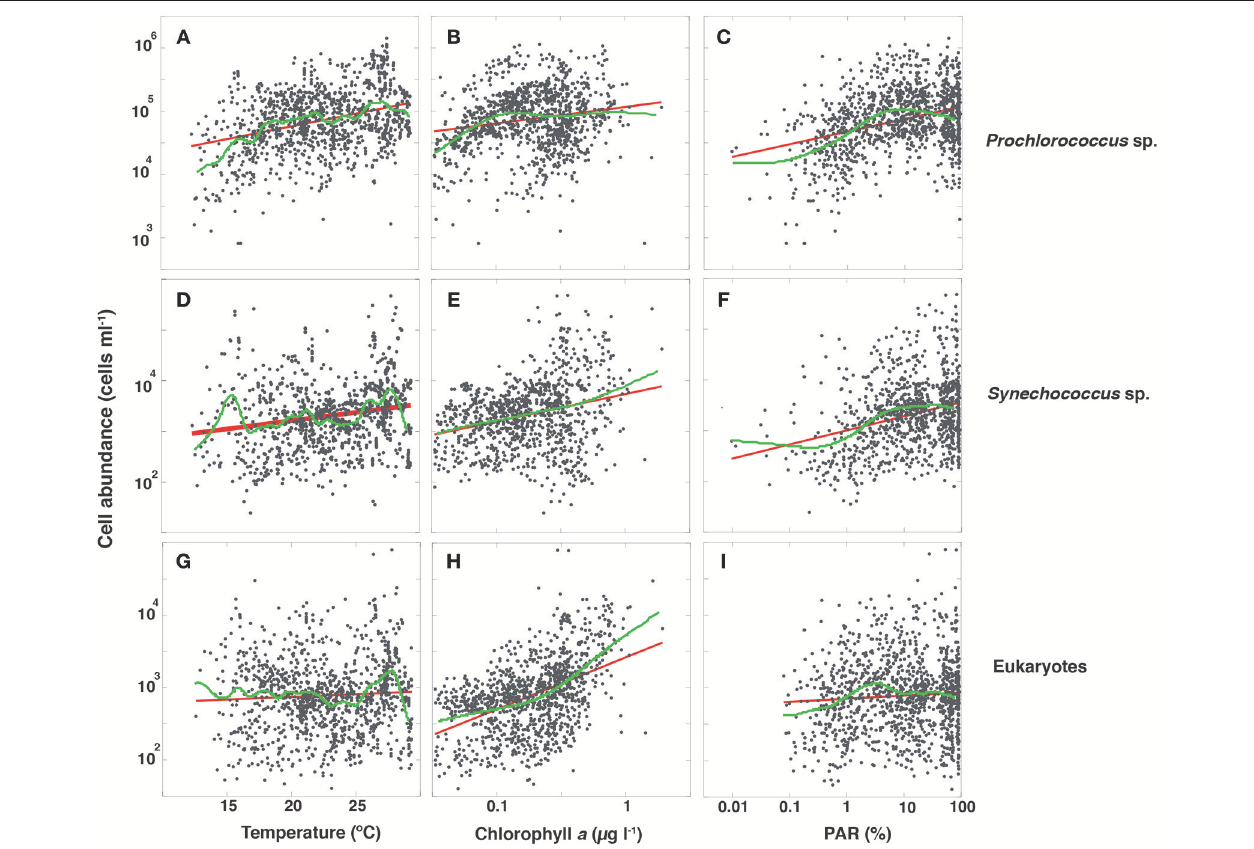
FIGURE 3 | The relationships between log 10 picophytoplankton abundance and temperature, log 10 chlorophyll a , and log 10 %PAR data compiled along the Malaspina-2010 Expedition. All oceans and sampling depths are included. Each panel contains the fitted linear (red line) and smoothing spline fit (lambda = 1, green line). The smoothing spline fit was not used in the models for projections. (A) Prochlorococcus abundance vs. temperature (Linear fit, R 2 = 0.111, P < 0.0001; Smoothing spline fit, R 2 = 0.172). (B) Prochlorococcus relationship with chlorophyll a (Linear fit, R 2 = 0.033, P < 0.0001; Smoothing spline fit, R 2 = 0.097). (C) Prochlorococcus relationship with PAR (%) (Linear fit, R 2 = 0.119, P < 0.0001; Smoothing spline fit, R 2 = 0.200). (D) Synechococcus abundance relationship with temperature (Linear fit, R 2 = 0.038, P < 0.0001; Smoothing spline fit, R 2 = 0.141). (E) S ynechococcus relationship with chlorophyll a (Linear fit, R 2 =